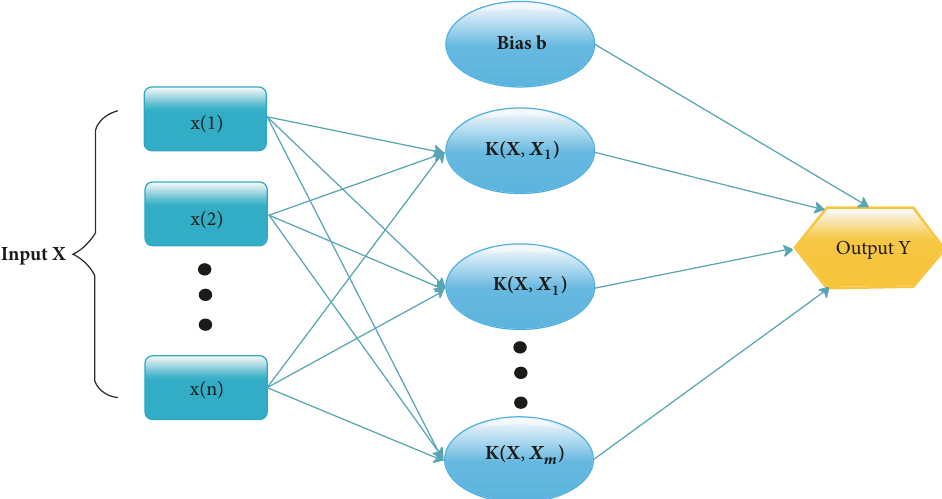
Figure 3: Topological structure of radial basis